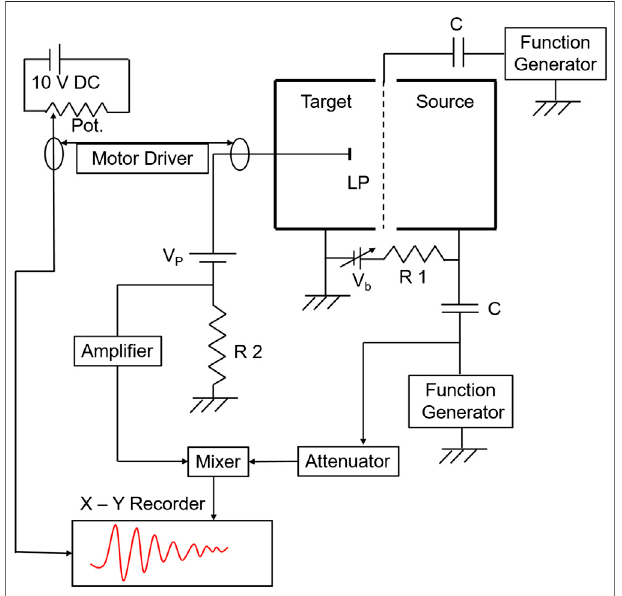
FIGURE3| Typicalinterferometerpatternfora500 kHzsignalatV HF (cid:2) 0 and 100 mV. The measured damping rates are also shown.